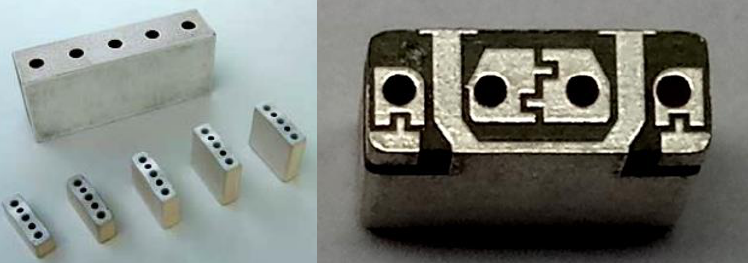
Fig. 1. The view of metalized ceramic blocks and classical topology of the 4th order filter with two attenuation